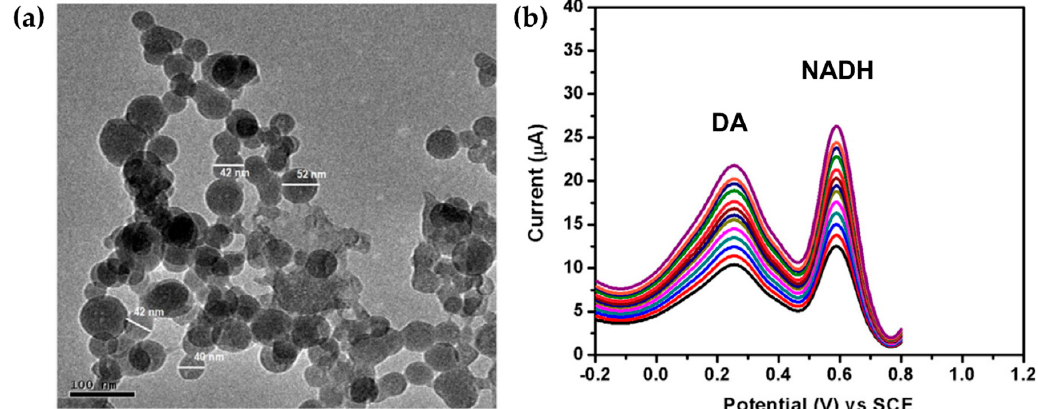
Figure 2. ( a ) TEM micrographs of poly(o-anisidine) (POA)-silver nanoparticles (AgNPs) hybrid (ratio 3:1); ( b ) differential pulse voltammograms of POA-AgNPs in 0.1-M PBS (pH 7.0) containing different concentrations of dopamine (DA) and nicotinamide adenine dinucleotide NADH (from inner to outer). Adapted with permission from reference [59]. Copyright © 2017 Elsevier B.V.